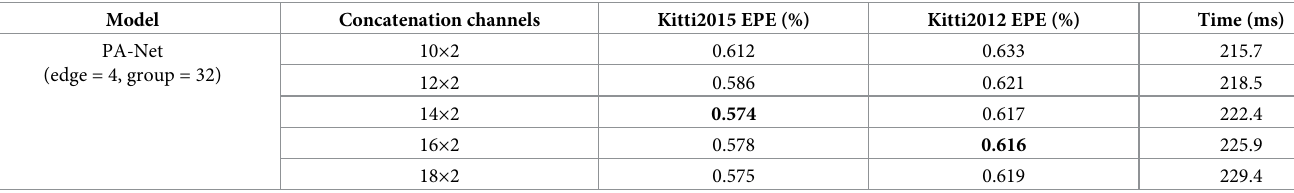
Table 5. Ablation study results of PA-Net with different settings on the dataset of KITTI.